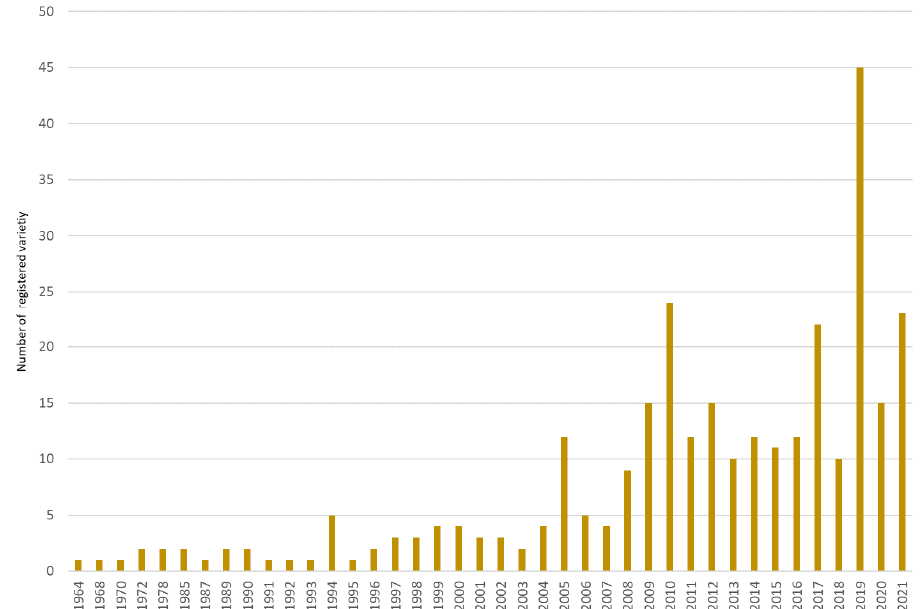
Figure 7. Number of field pea varieties according to registration year from the national variety lists of the EU member states [47–64].